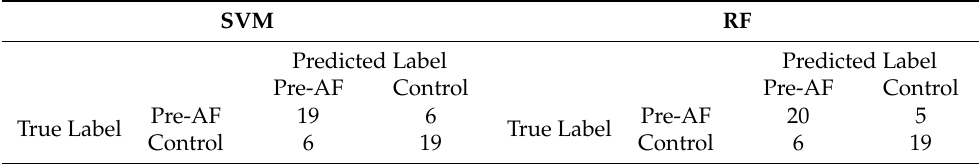
Table 2. Confusion matrix on the training data.